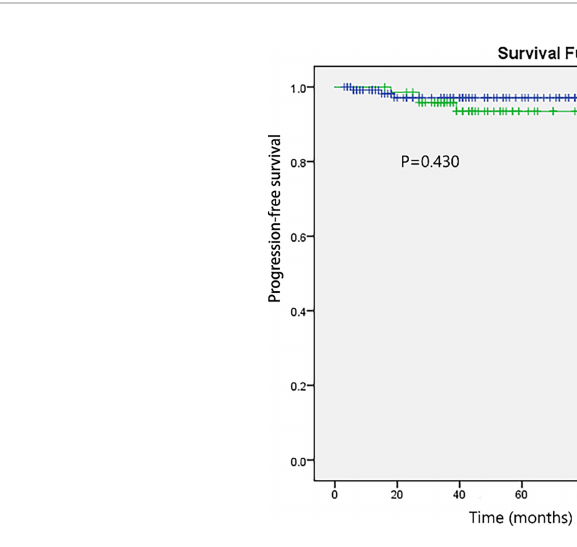
FIGURE 3 | Progression-free survival of laparoscopy and laparotomy in patients with early EOC.